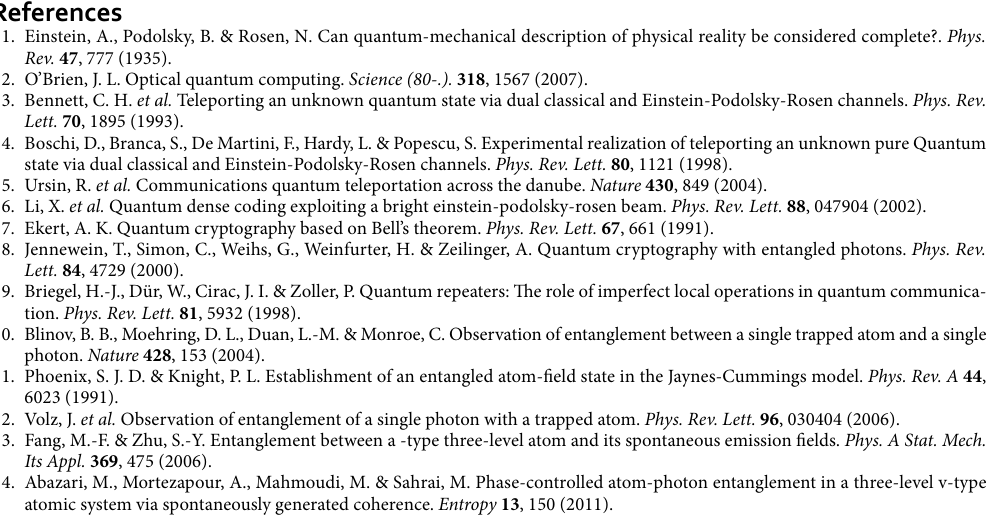
2 γ , and T B 7 γ ( a , b ) and T A 6 γ , and T B 1 γ . = = = = 2, l 1 1, p 1, w 0 2 mm, C l 1, (cid:31) 532 10 − 9 m, I 0 10 γ , p = = − = − = = = × =